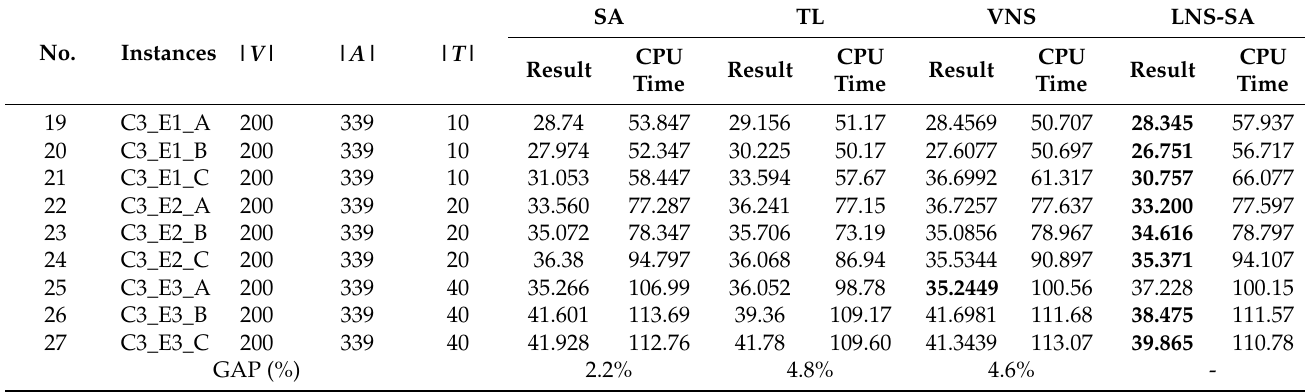
Table 6. Algorithm Performance on C3